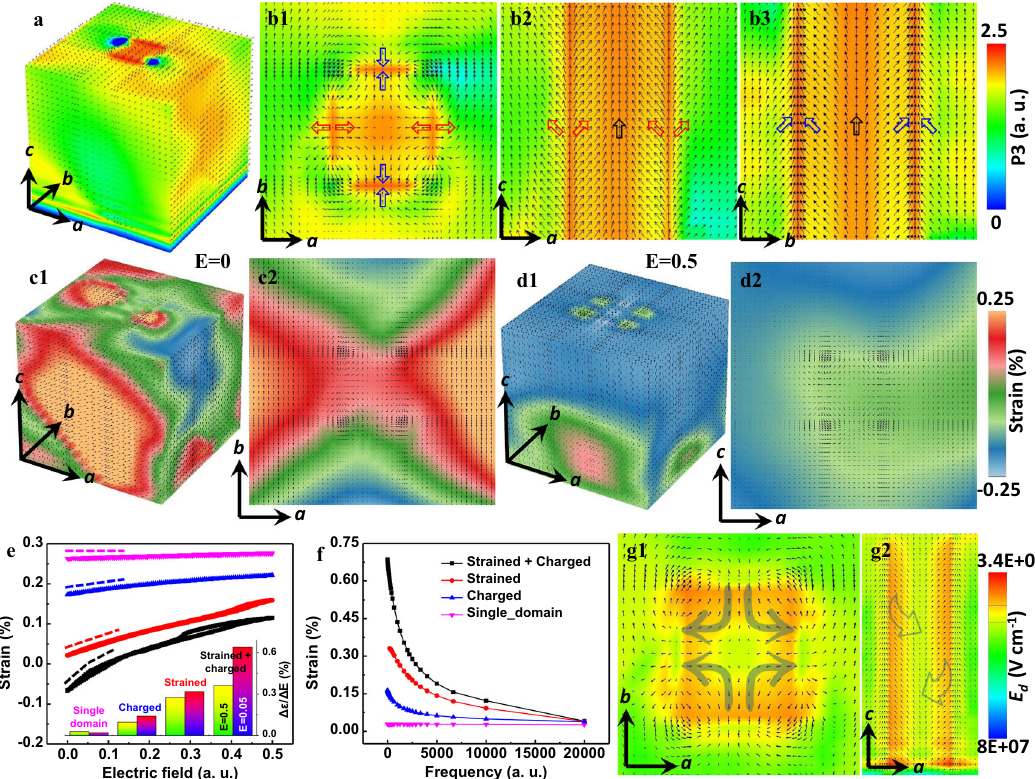
Fig. 4 Phase fi eld simulations of strained and charged OOP boundaries. a 3D view of the domain structure in a NNO fi lm with a strained and charged nanopillar. b1 – b3 2D slice images along c , b , a axes respectively at the middle section of a . Regions with different colors indicate ferroelectric domains with different polarization directions. c1 , c2 and d1 , d2 3D and 2D strain maps of the strained and charged NP-NNO fi lm at the initial state and under an applied electric fi eld of 0.5 a.u. (arbitrary unit) respectively. e Average effective electric- fi eld induced strain of single-domain NNO fi lm for only strained, only charged, and charged + strained NP-NNO fi lms. The frequency is 10 a.u. The inset is the strain change over the electric fi eld range of 0.05 and 0.5. f Average effective electric- fi eld induced strain as a function of frequency of the four cases in e with an applied electric fi eld of 0.05 a.u. g1 , g2 2D slice images along c and b axes, respectively showing the depolarization fi